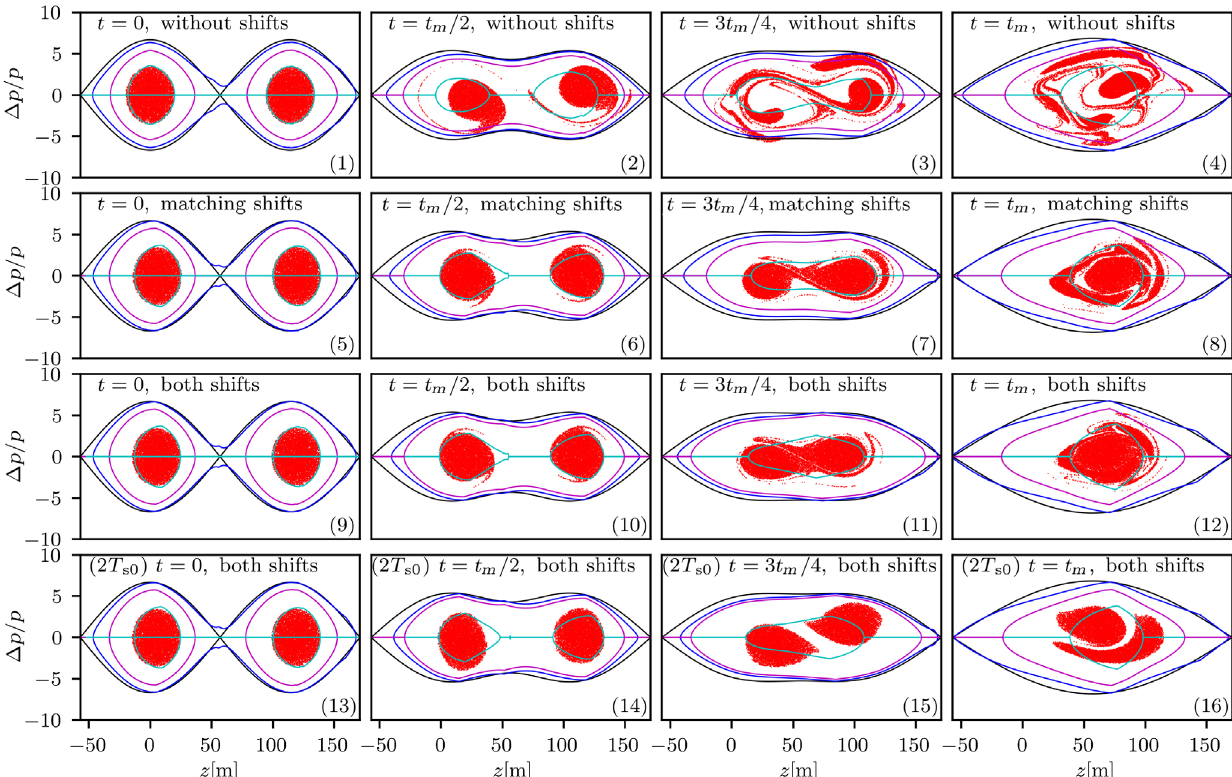
= 2 ), three quarter ( t ¼ 3 t = 4 ) and the end ( t ¼ t FIG. 12. Snapshots of phase-space distributions at the initial ( t ¼ 0 ), half ( t ¼ t ) of m m m bunch merging with merging time of 10 T , in the presence of both space charge and beam loading for three cases. Upper panels (1) to s 0 ; i (4): simulations without matching shift and without symmetry shift; Middle panels (5) to (8): with matching and without symmetry shift; Lower panels (9) to (12): with both matching and symmetry shift. The purple lines are the separatrix orbit of the combined harmonics affected by the beam loading and space charge, compared with the ideal separatrix without beam loading and space charge (in blue). The two curves in cyan and purple denote two trajectories of constant Hamiltonian including space charge and beam loading. For ¼ 2 T comparison, panel(9) to (12) displays the fast bunch merging with t m s 0 ; i combined effects of space charge and beam loading, calculated from the generalized elliptical bunch model. In comparison, the black lines indicate the ideal separatrix distortion inside the bucket, two phase-space trajectories with specified values of Hamiltonian are plotted within each bucket. The orbits in light blue (cyan) color represent the contour passing through the position of the ideal bunch boundary (named as “ reference bunch contour ” for con- venience in the following). The orbits in purple denote the contour with doubled ideal bunch boundary. The bunch behavior during bunch merging under intensity effects in Fig. 12 is discussed as follows: (i) The bunch merging process initially mismatched to beam loading is shown in panels (1) to (4). The mismatch in panel (1) can be seen by the offset between the (light blue) reference bunch contours in panel (1) and in panel (5). The initial mismatch leads to obvious dipole oscillations (indicated by the offset of the bunch centers to the bucket centers) in panel (2). Due to beam loading, the (light blue) reference bunch contours in panel (1) are evolved into asymmetrical islands in panel (2).